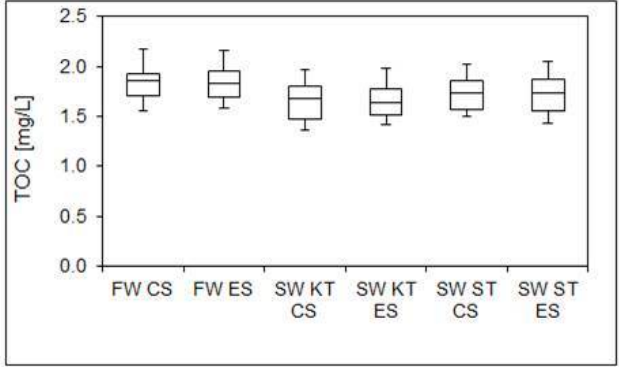
Figure 3. TOC concentrations in fresh (FW) and stagnant water samples (SW) in the conventional (CS) and extended system (ES) at the kitchen tap (KT) and shower tap (ST). Number of fresh samples (inlet, kitchen and shower) = 48. Number of samples per tap = 16, SD < 2%.